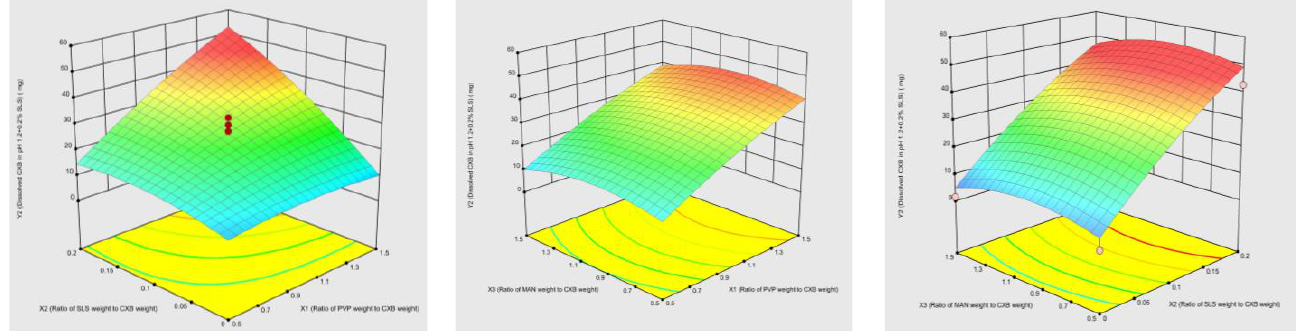
Figure 2. Three-dimension response surface showed the effects of PVP/CXB weight ratio (X 1 ), SLS/CXB weight ratio (X 2 ) and MAN/CXB weight ratio (X 3 ) on the dissolved amount in pH 1.2 + 0.2% SLS after 120 min (Y 2 ).